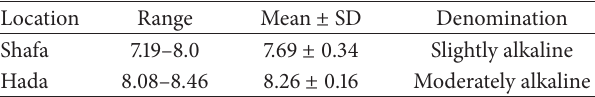
Table 1: pH of soil collected from Shafa and Hada farms.